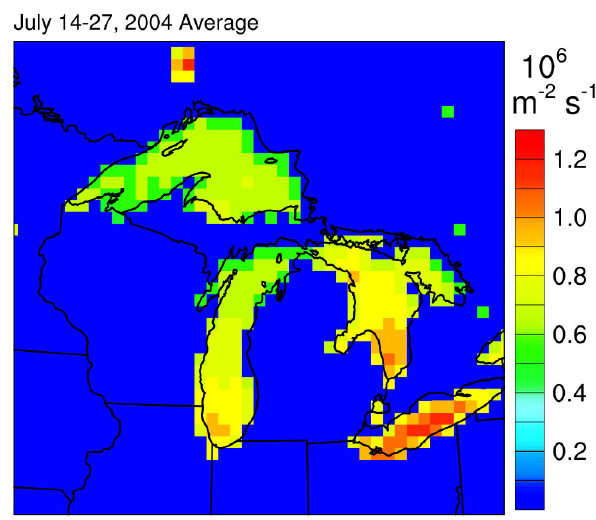
Fig. 7. Simulation results averaged over the 14–27 July 2004 two- week period: wind-generated aerosol number flux (10 6 m − 2 s − 1 ) over the Great Lakes